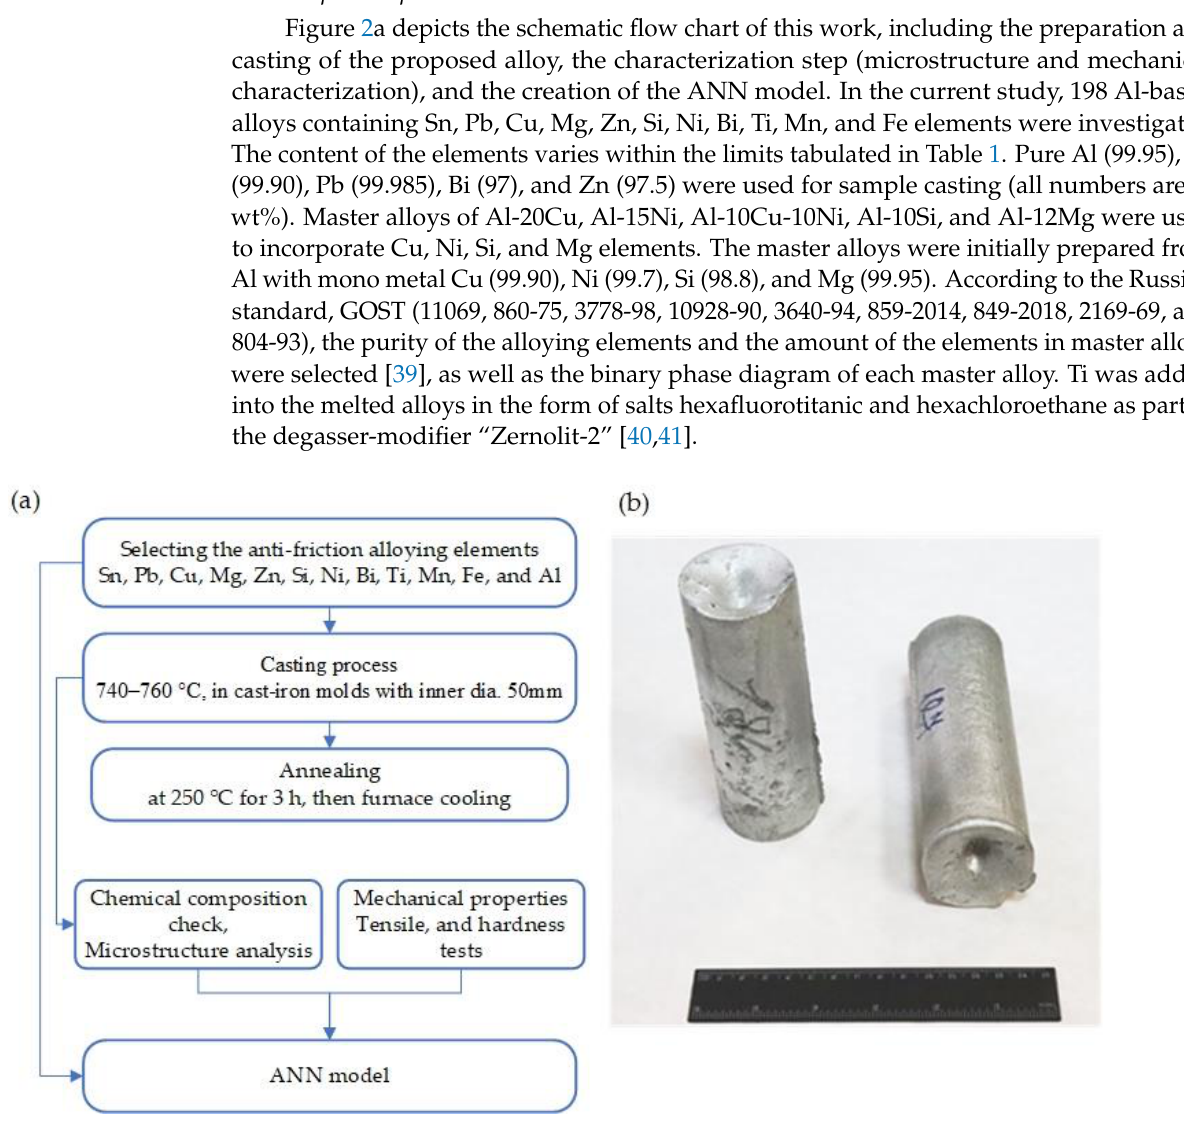
Figure 2. ( a ) Schematic flow chart of this work. ( b ) Image of the as-casted ingots of the investigated alloys poured in the iron mold. alloys poured in the iron Table 1. The chemical composition of the added alloying elements to Al-based anti-friction alloys. Element